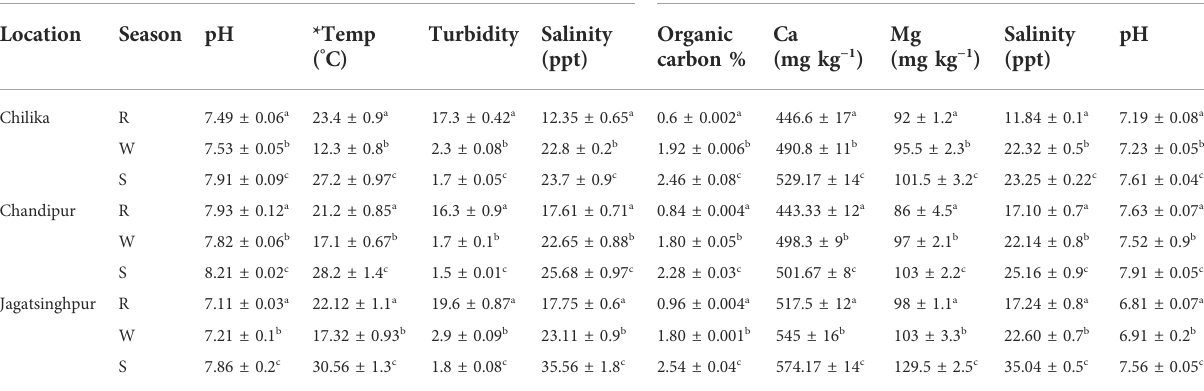
TABLE 1 Spatio-temporal pattern of pedology and hydrology of sampling sites. Water quality of S. serrata of all sampling sites Soil quality of S. serrata of all sampling